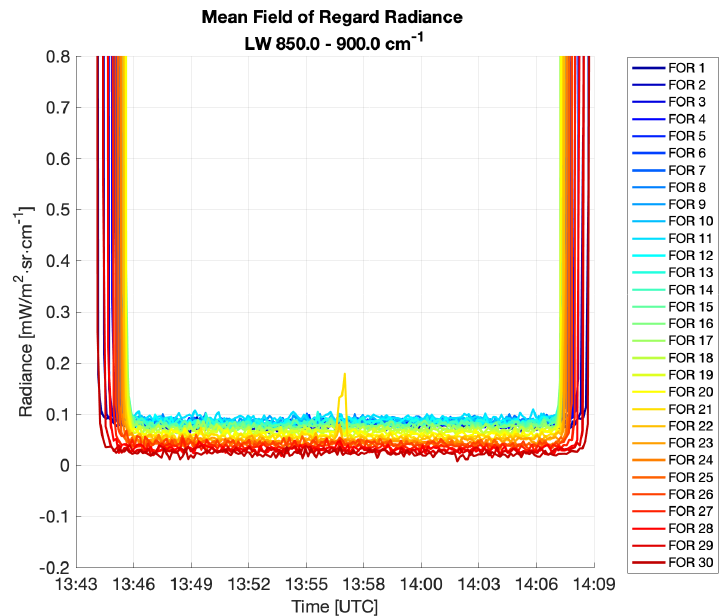
Figure 8. The NOAA-20 CrIS radiance time series for a spectral average from 850–900 cm − 1 and averaged over all nine fields of view during the pitch maneuver.